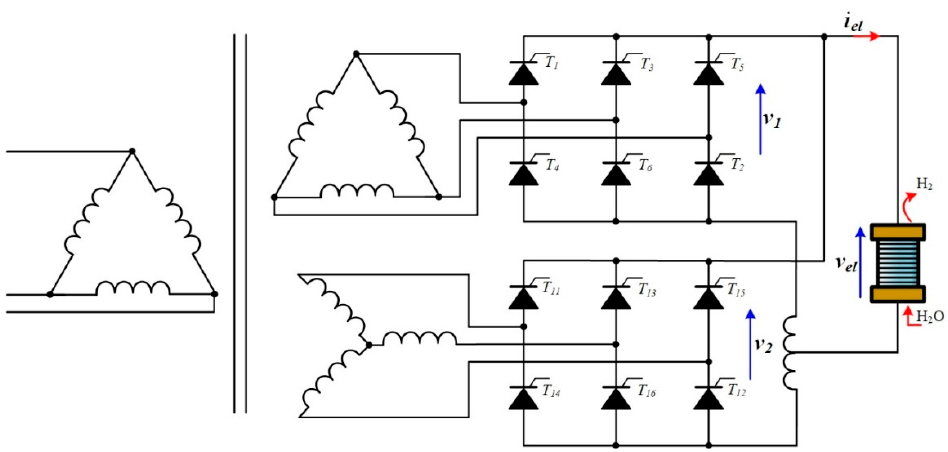
Figure 9. 12-pulse thyristor bridge rectifier.